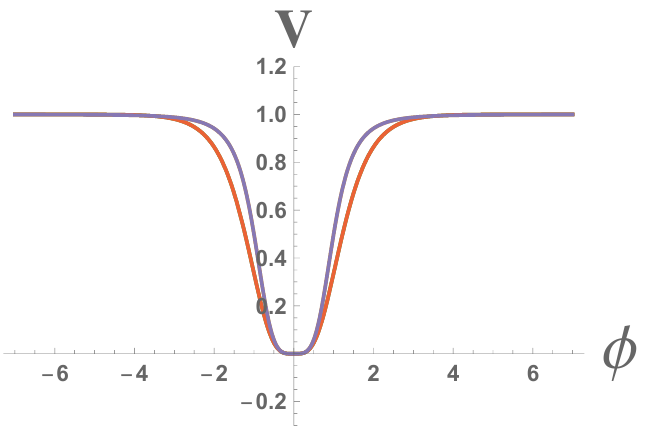
with (cid:11) = 1 = 6. The p 6 (cid:11) for m = 1. In both cases we have plateau (cid:30) 4 + m 4